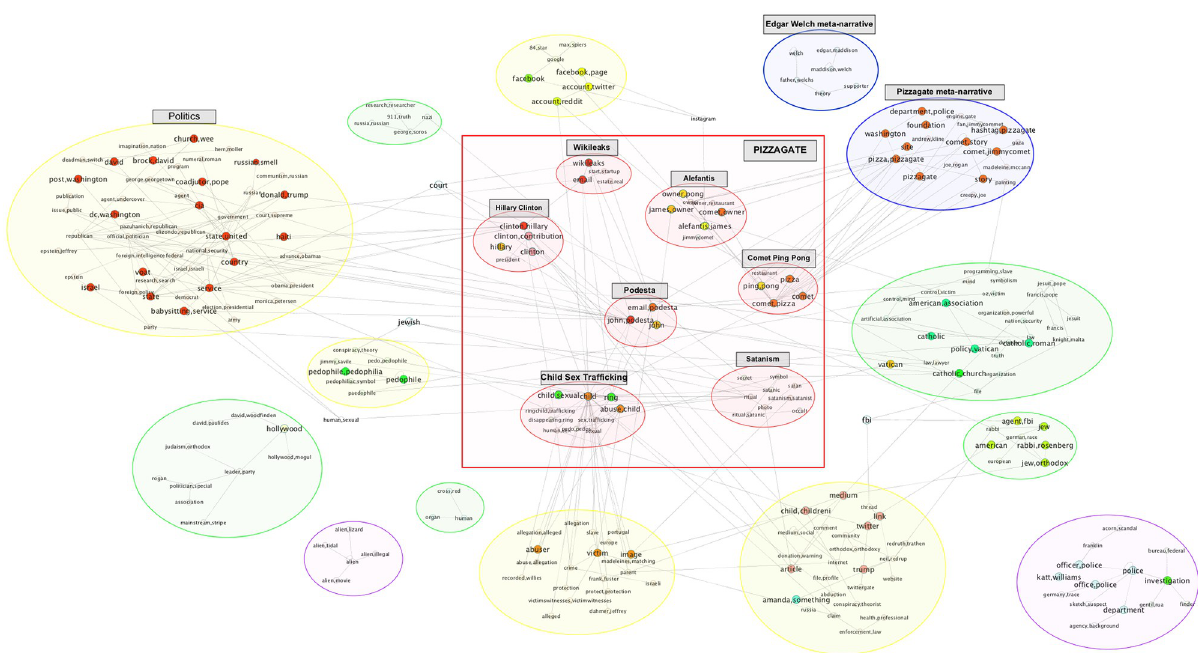
Fig 10. Community detection on the overall Pizzagate corpus. Subnodes are colored based on their assigned community, while all relationships between any two subnode actant nodes are collapsed to a single edge. Solid core nodes have an assignment based on the P ¼ 0 : 7 threshold, while th 1 open shared nodes have an assignment based on P ¼ 0 : 4 threshold (see Algorithm 1). Main Pizzagate supernodes are outlined in red, and include th 2 their subnodes colored by community. Meta-narrative frameworks are shaded with blue. Context groupings are shaded with yellow, while narrative framework nucleations are shaded with green. Unrelated discussions are circled in purple. The entire Pizzagate narrative framework is highlighted with a red box (see Fig 8 for a frequency-filtered version of this